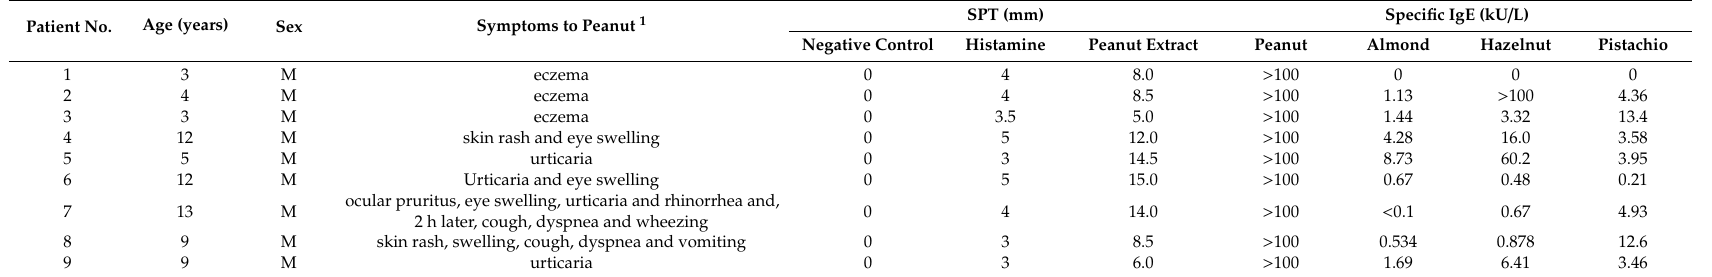
Table 1. Clinical and sensitization profiles of the peanut-allergic